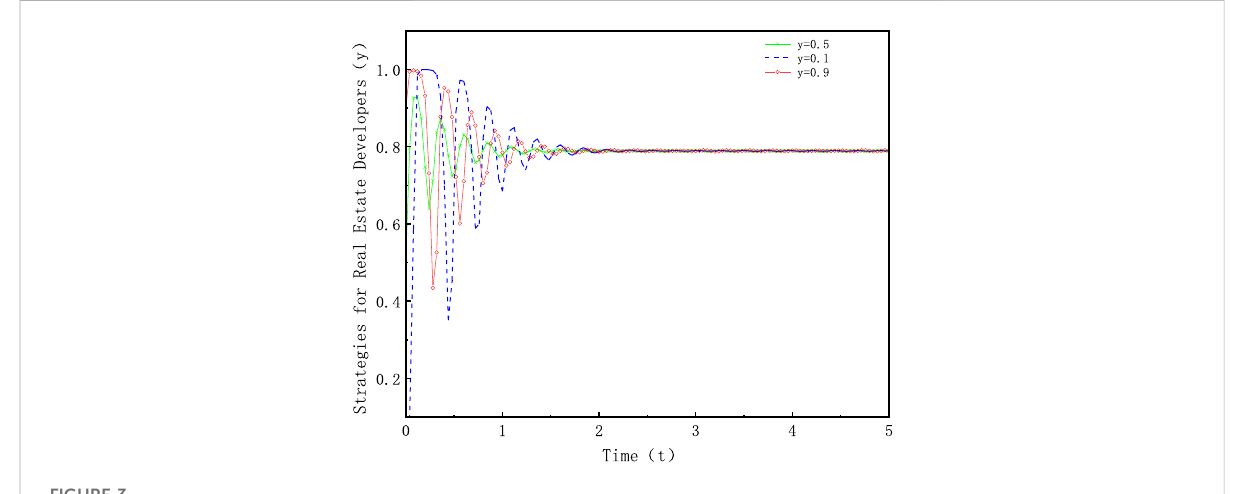
FIGURE 3 Strategies evolution of property developers under different initial values.